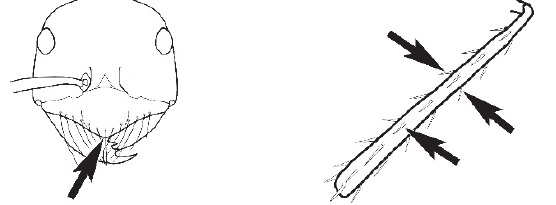
In full-face view, psammophore in a row slightly above anterior clypeal margin; anterior margin of clypeus acuminate at its midpoint; metatibia may have more than two rows of preapical spines ( M . bagoti complex) ............. 15